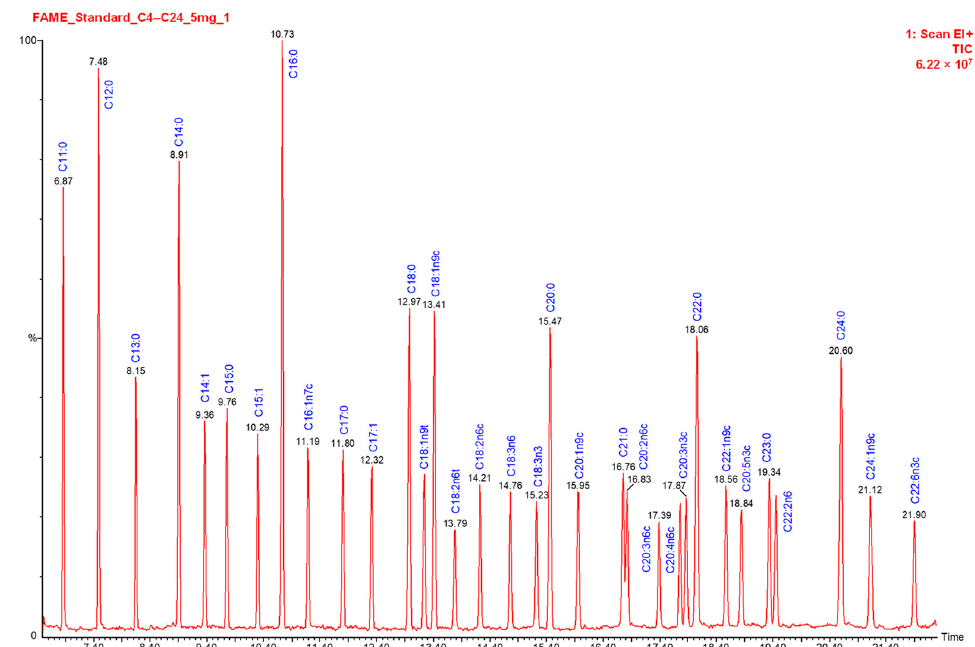
Figure 2. Chromatographic separation of C 4 -C 24 FA methyl ester standards with reference to their